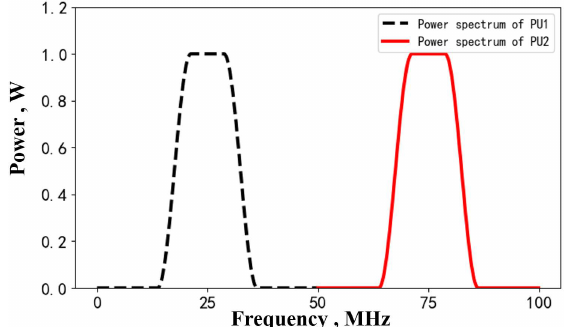
Figure 8. The power spectrum of PU1 and PU2 in the testing